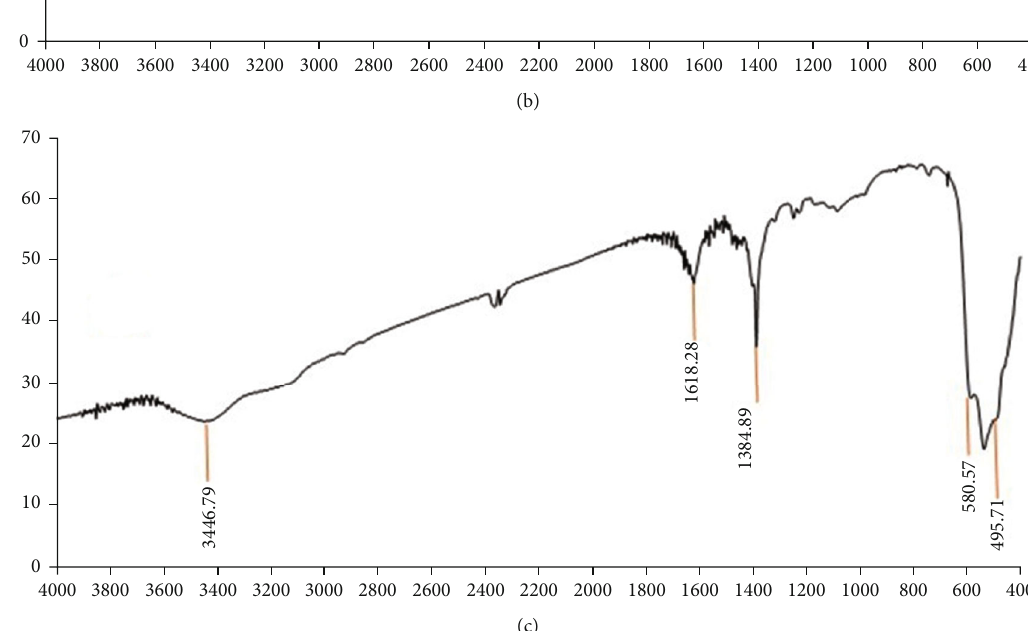
L) , and (c) CuO 2 2